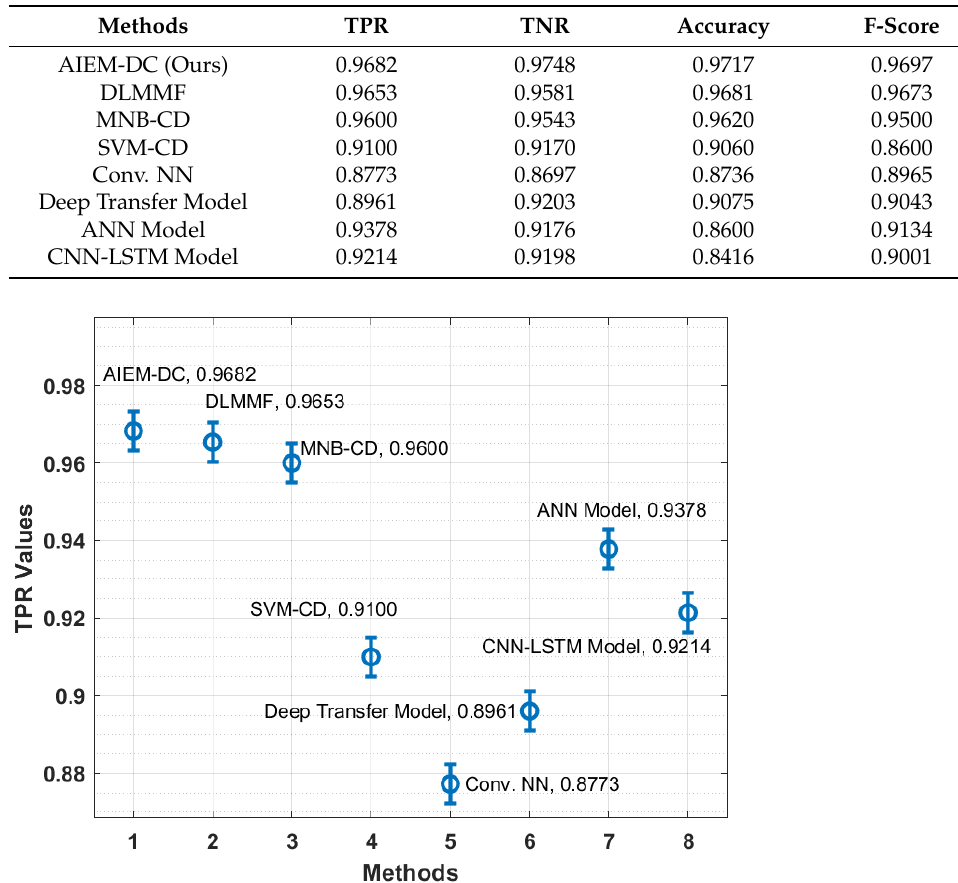
Figure 6. TPR analysis of AIEM-DC model with existing approaches.